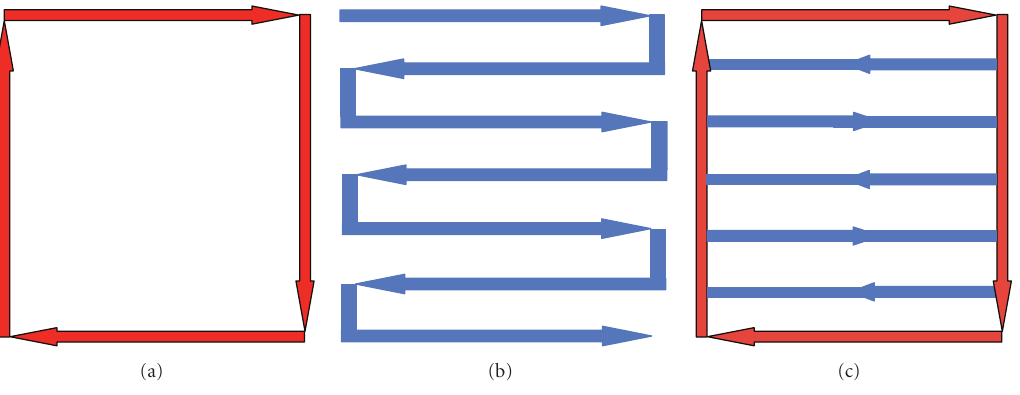
Figure 2: Deposition strategies: (a) contour, (b) raster, (c) raster and